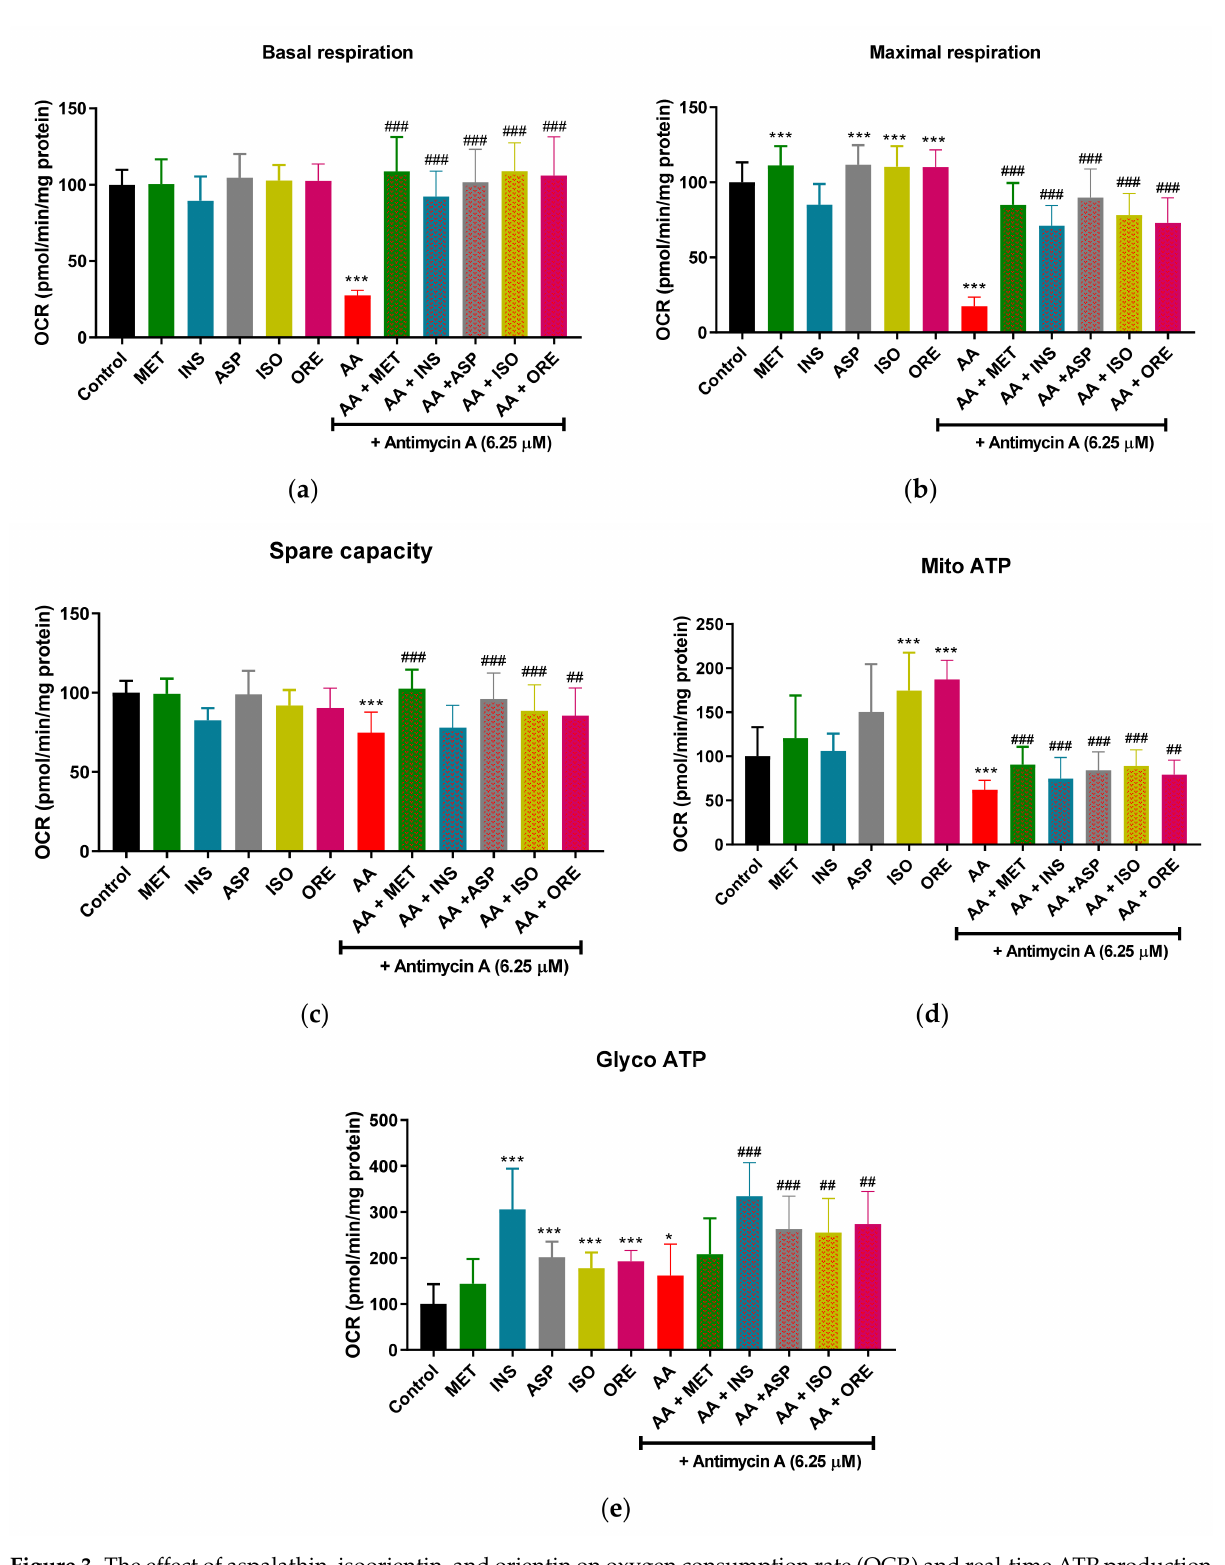
Figure 3. The effect of aspalathin, isoorientin, and orientin on oxygen consumption rate (OCR) and real-time ATP production in C2C12 skeletal muscle cells. Briefly, figure panels ( a – e ) represent basal respiration, maximal respiration, spare capacity, mitochondrial ATP, and glycolytic ATP, respectively. C2C12 were treated with antimycin A (6.25 µ M) for 12 h followed by treatment with aspalathin, isoorientin, orientin (10 µ M), and comparative control metformin (1 µ M) for 4 h. Insulin (1 µ M) for 30 min. Results are expressed as mean ± SD of three independent experiments. * p < 0.05, *** p < 0.001 versus normal control; ## p < 0.01, ### p < 0.001 versus antimycin A